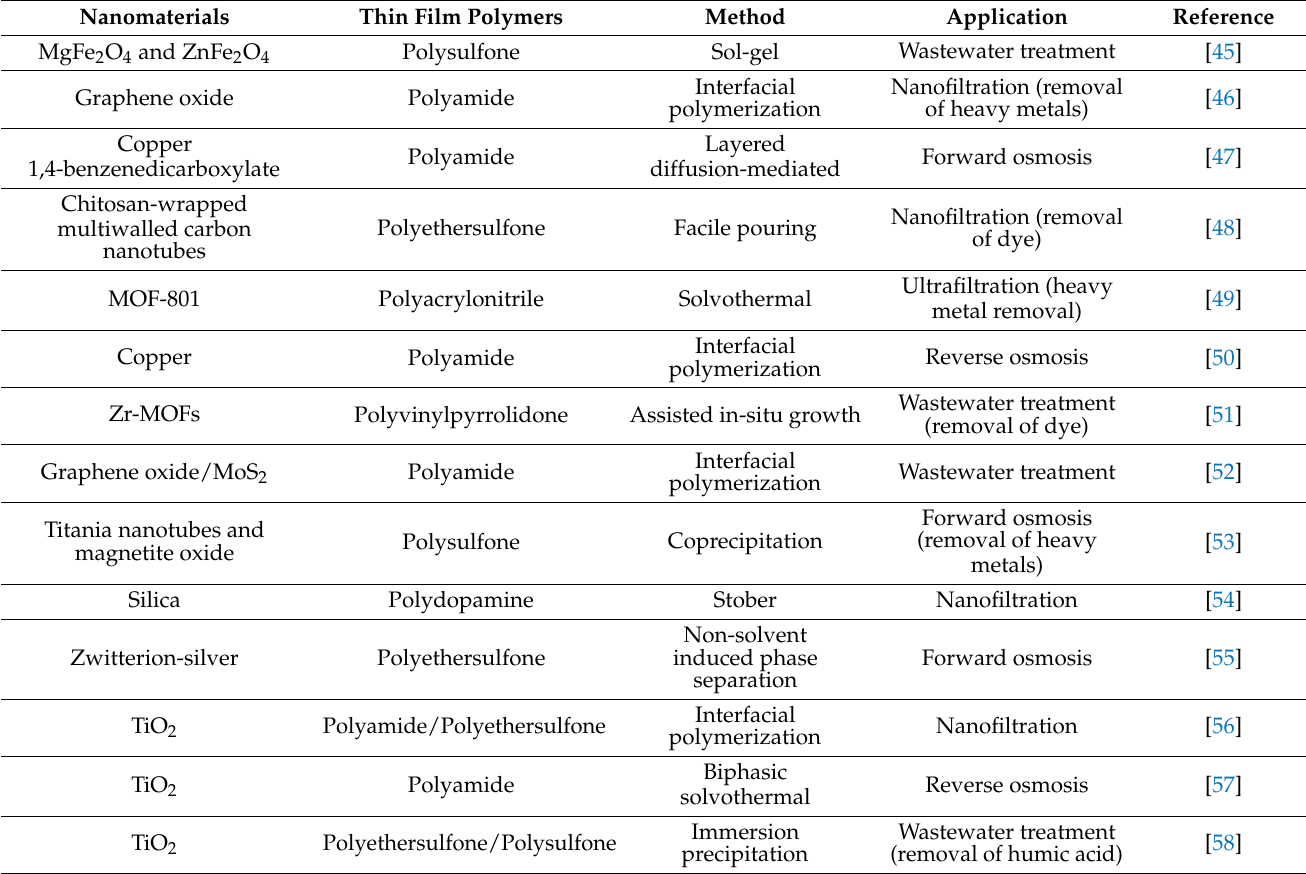
Table 2. Application of thin-film polymer